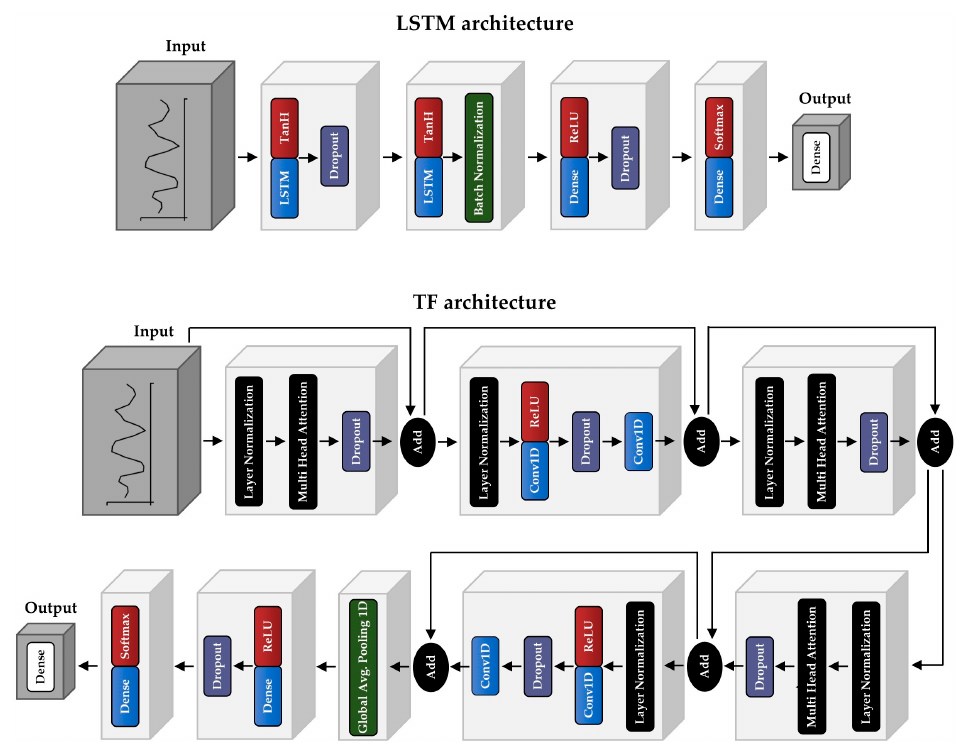
Figure 2. LSTM and TF architectures used in models .